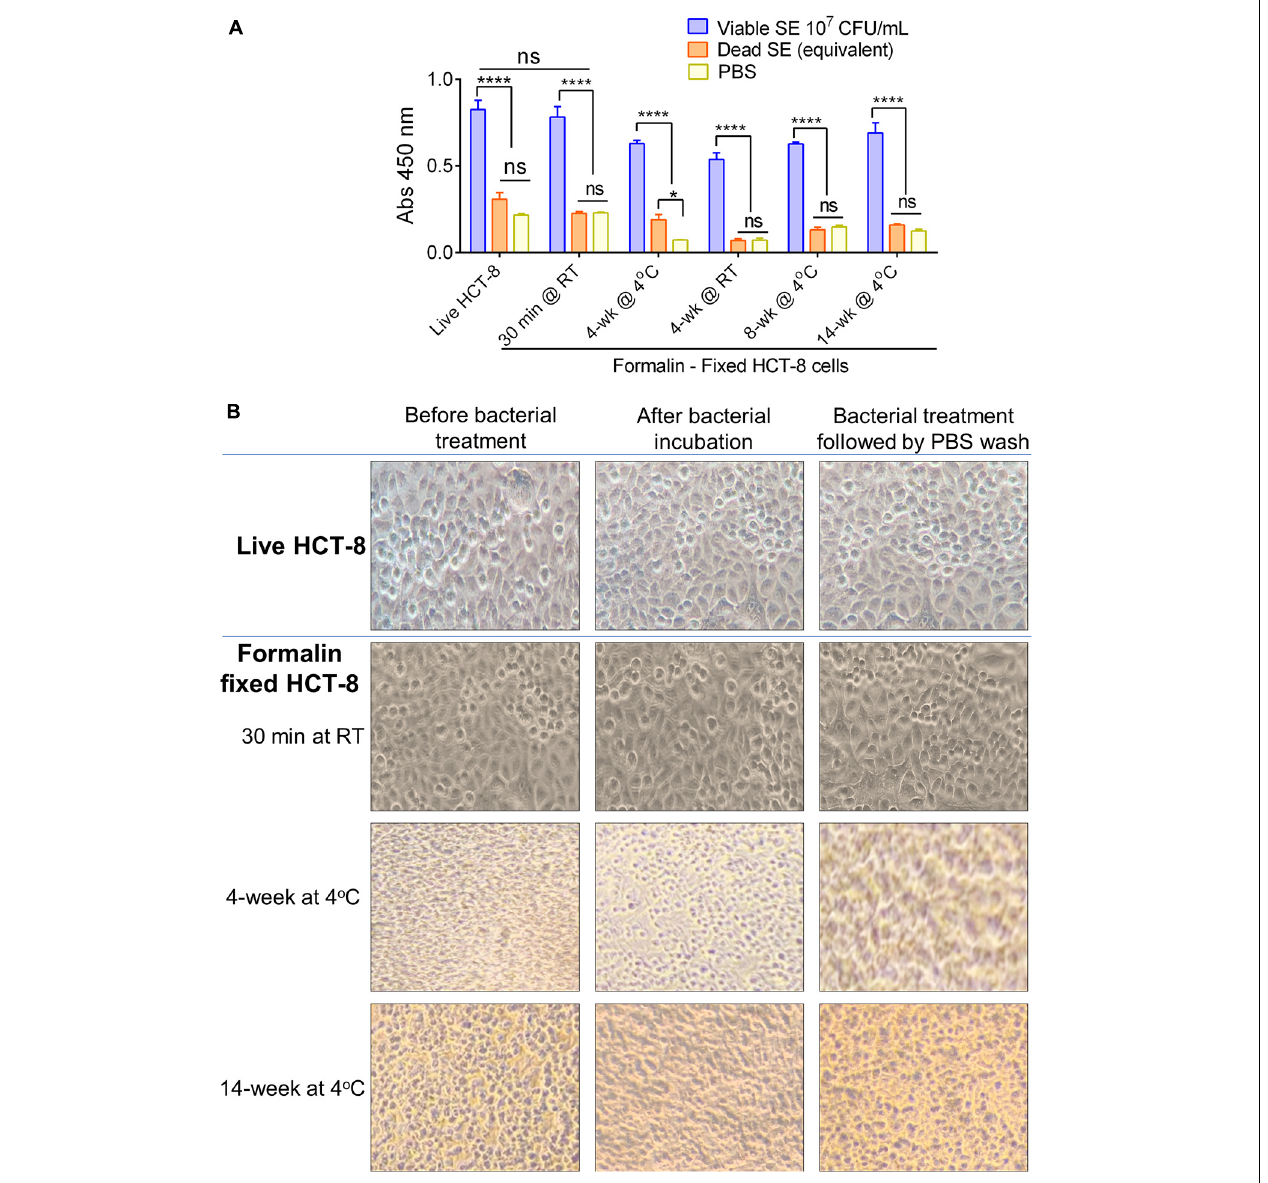
FIGURE 7 | Performance of MaCIA after prolonged storage. (A) Comparison of MaCIA signals (absorbance reading) of S . Enteritidis cells (1 × 10 7 cells/ml) originating from live HCT-8 and formalin-fixed HCT-8 cells stored at 4 ◦ C for 30 min to 14 weeks. (B) Light microscopic analysis of cell morphology of formalin-fixed HCT-8 cells stored up to 14 weeks. Panels showing intact cell morphology before bacterial treatment, after treatment, and after PBS wash. Magnification, 400 × . Error bars represent SEM. **** P < 0.0001; ns, no